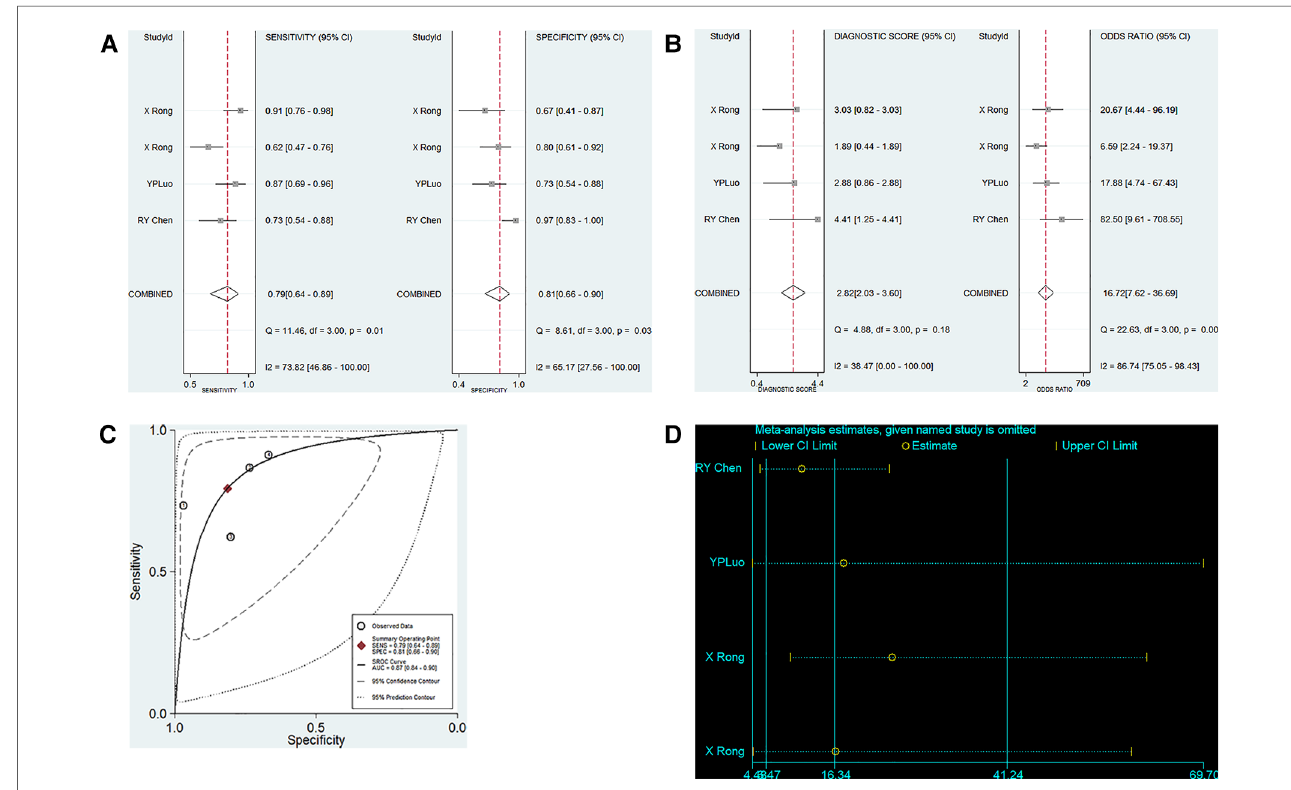
FIGURE 5 Pooled results of the studies on ncRNAs differentiating acute KD patients from convalescent KD patients among 4 studies included in the meta-analysis. ( A ) Pooled sensitivity and speci fi city; ( B ) Pooled DOR; ( C ) SROC. ( D ). Sensitivity analysis of the results of the meta-analysis for ncRNAs differentiating acute KD patients from convalescent KD